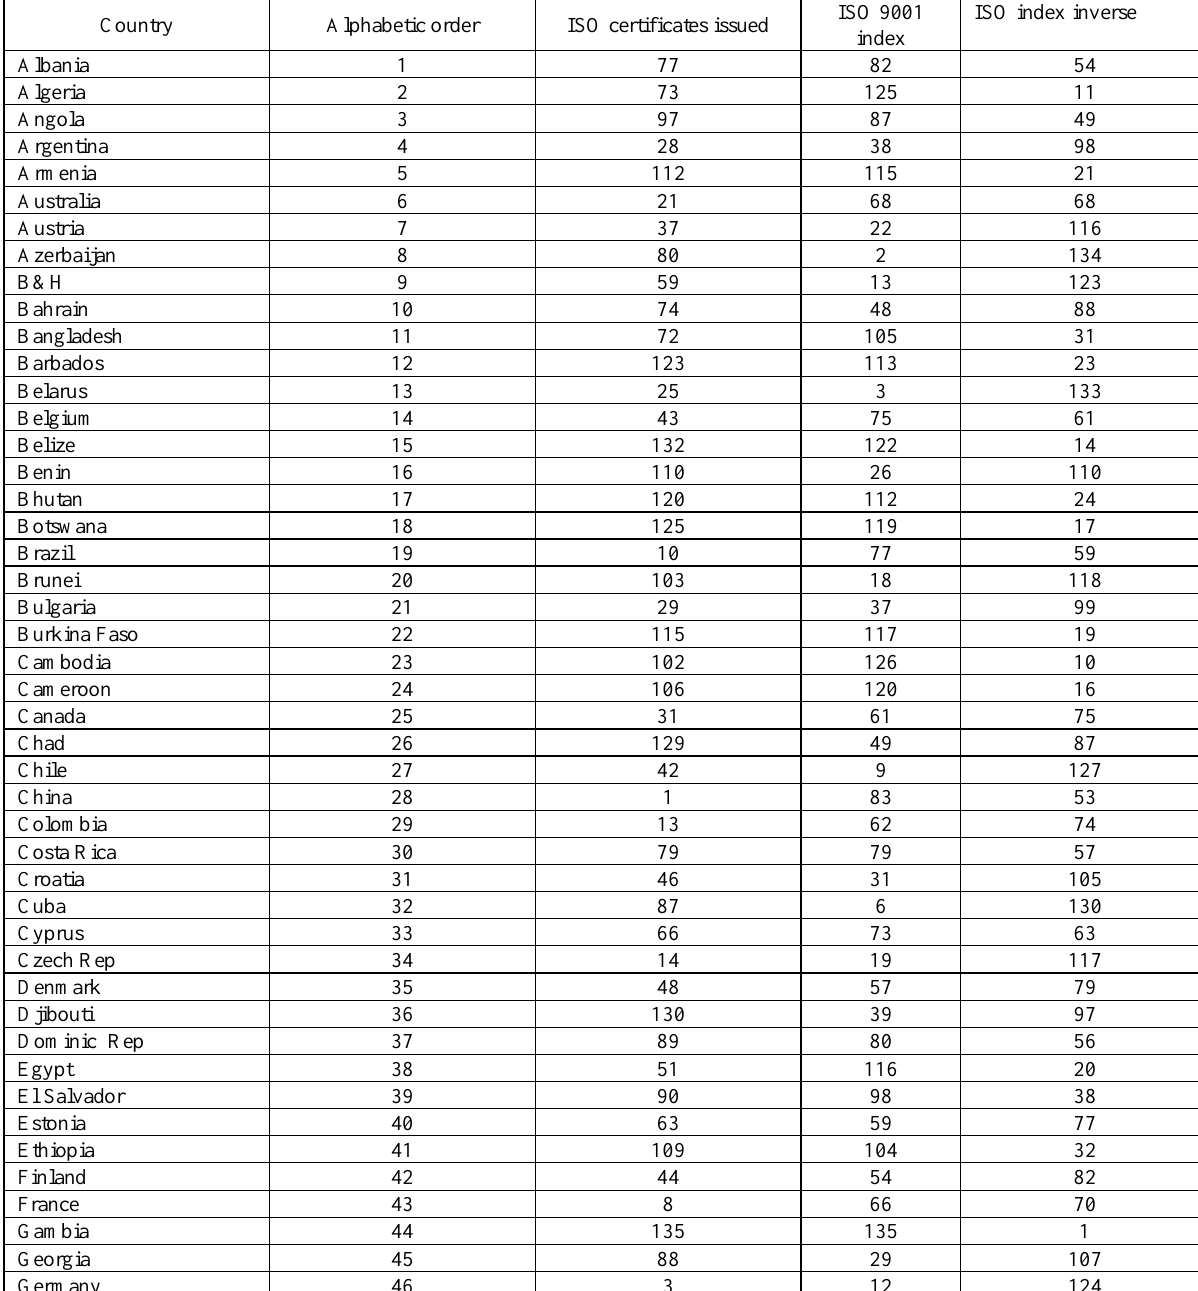
Table 4. The rank of countries as per the alphabetic order, number of ISO 9001 certificates, and as per the ISO 9001 index (136 countries